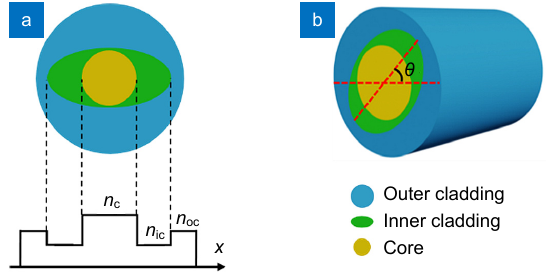
Fig. 3 | ( a ) Cross section and refractive-index distribution of the IECF. ( b ) Three-dimensional structure of the